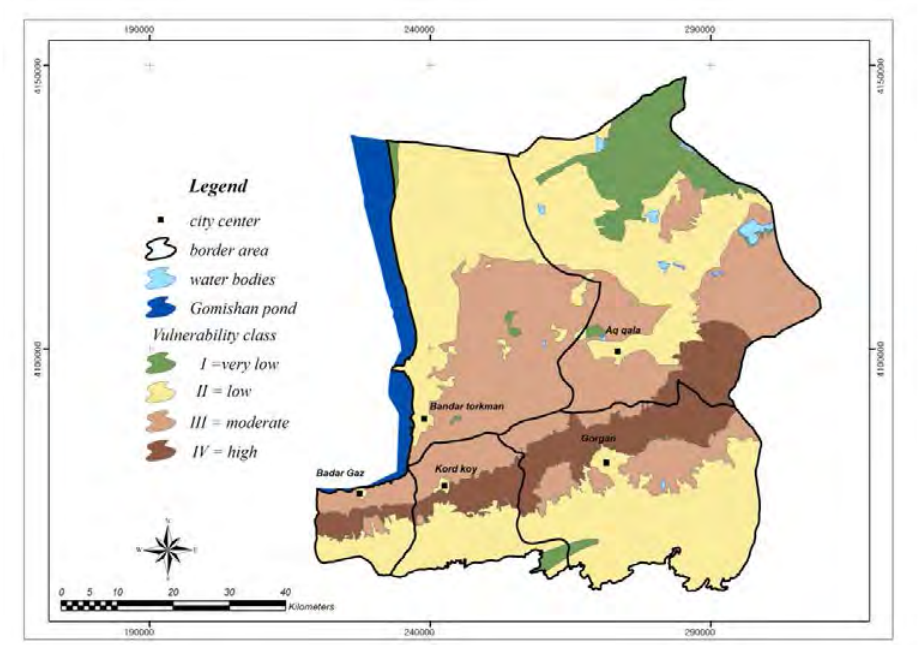
Fig. 5: Class map of the vulnerability of the elements at risk in the study area